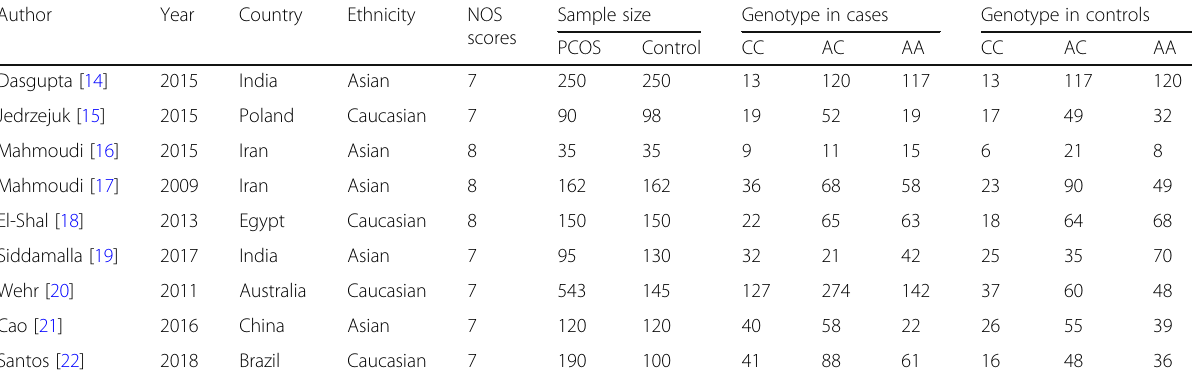
Table 1 Characteristics of studies on VDR ApaI rs7975232 (A > C) variant and polycystic ovarian syndrome (PCOS) susceptibility